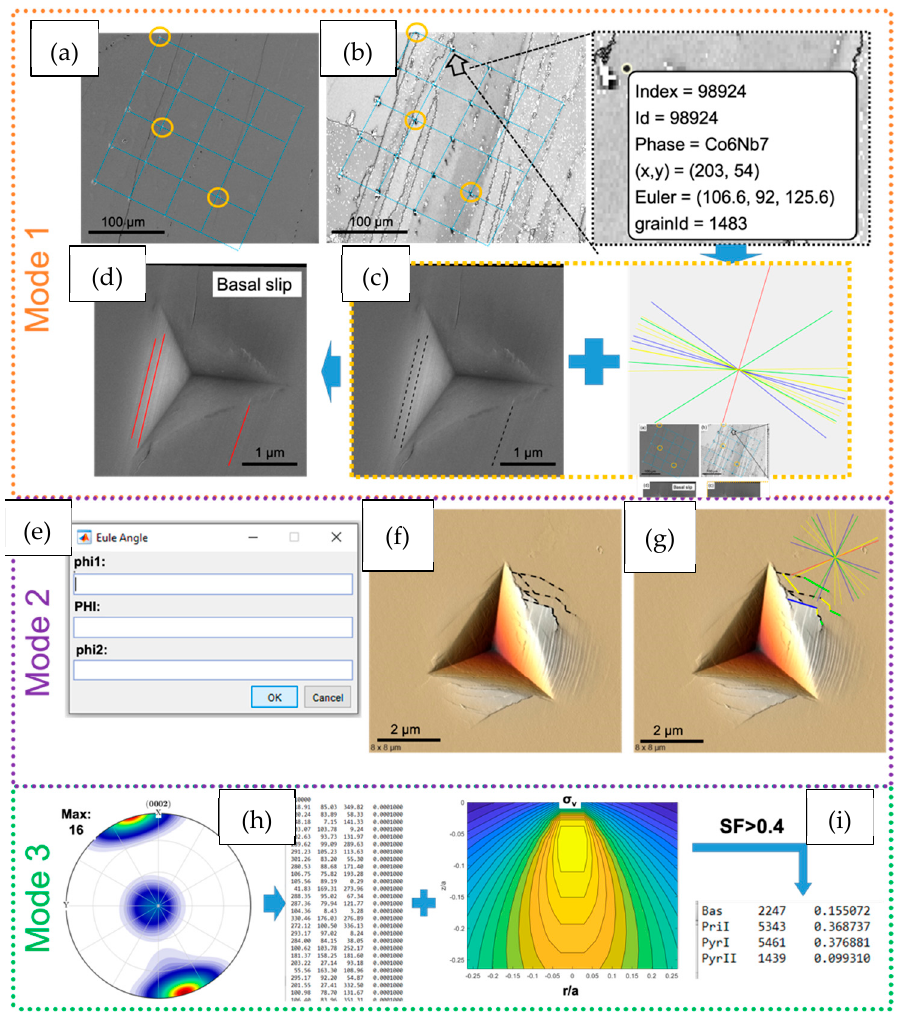
Figure 5. Examples of indents analysed in mode 1, mode 2 and mode 3. ( a ) In mode 1, the three points indicated by the yellow circles are used to align the EBSD and SE images. ( b ) The indent of interest is selected from the EBSQ-IQ map, ( c ) the corresponding SE image is uploaded, and the slip lines are marked by the user. ( d ) The code subsequently identifies the operating slip planes, and colours them accordingly. ( e ) In mode 2, the Euler angles are provided by the user, ( f ) the slip lines are marked by the user on the AFM image, ( g ) and then these are assigned to slip planes and coloured accordingly. ( h ) In mode 3, the global texture of the sample is defined as an input and discritised into 10,000 orientations. ( i ) The stress field under an indent is calculated for these orientations, and slip systems showing a Schmid factor >0.4 are assumed to be active. The indents shown in ( b – d ) are made in a Nb 6 Co 7 µ -phase, produced by arc melting and annealed for 1000 h at 1100 ◦ C and mechanically polished down to a colloidal silica finish. The indents in ( f , g ) are in the same Fe 7 Mo 6 µ -phase sample described in Figure